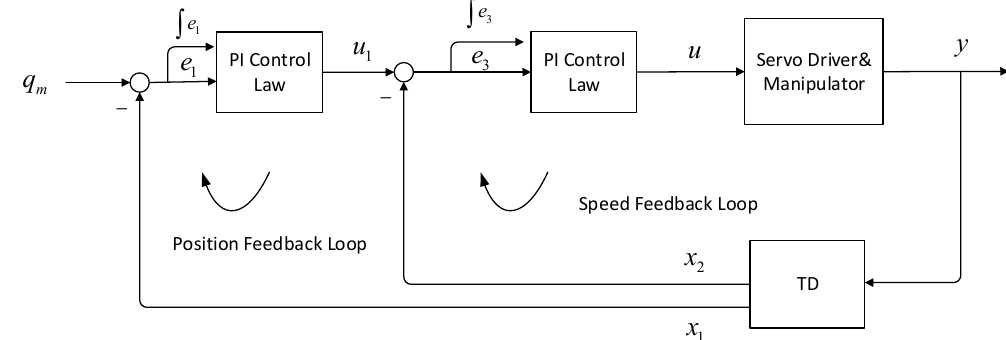
Figure 8. Robot uniaxial PI controller.